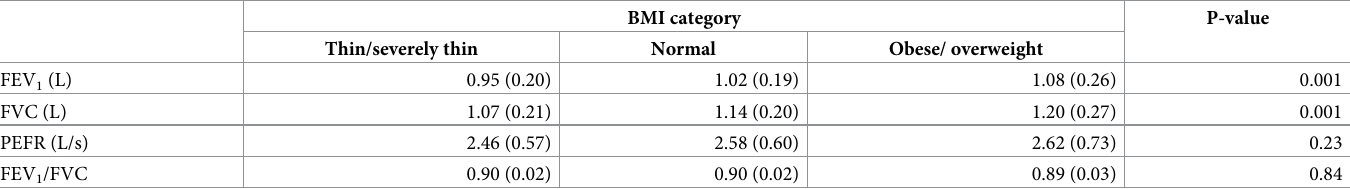
Table 2. Relationship between spirometry parameters and BMI